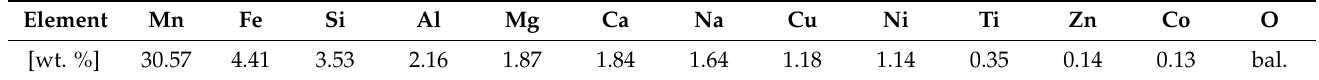
Table 1. Chemical composition (XRF) of the deep-sea nodules (in wt. %)